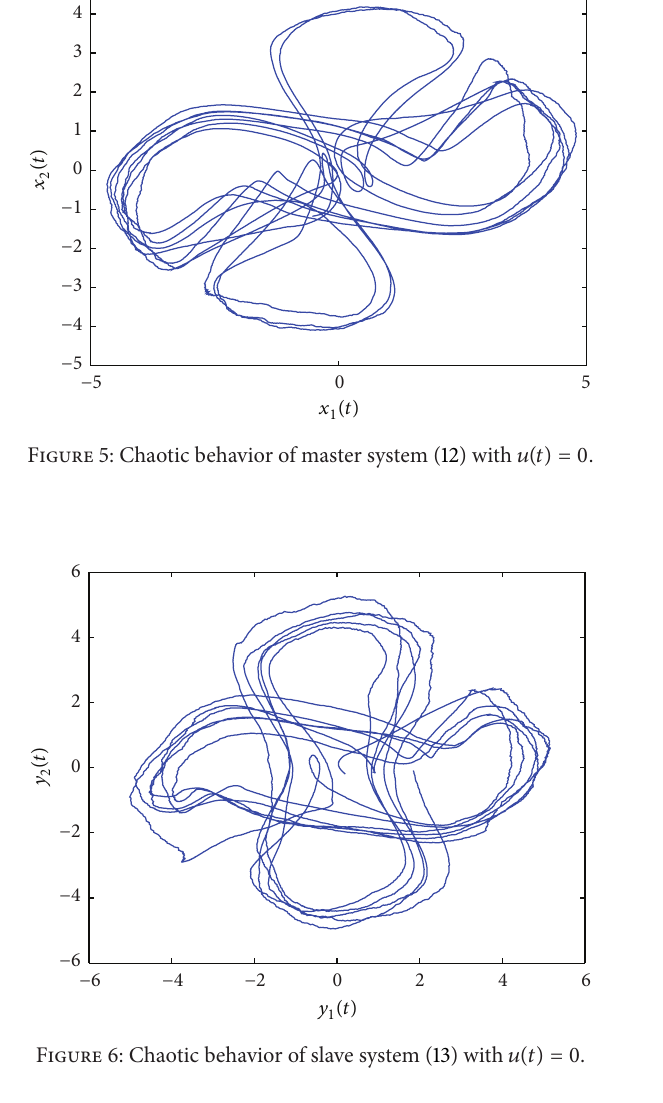
Figure 8: State responses of error system